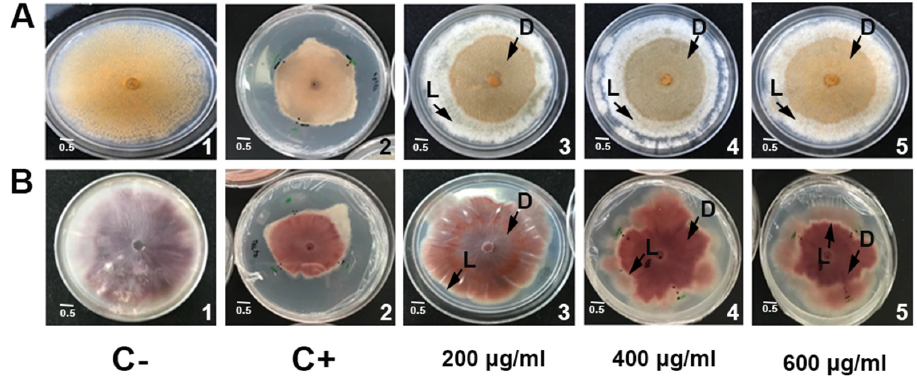
Figure 2. PaSn antifungal activity in vitro against phytopathogens using different peptide concen- trations ( A ) Colletotrichum gloeosporioides (1–5), and ( B ) Fusarium oxysporum (1–5) mycelial growth trations ( A) Colletotrichum gloeosporioides (1–5), and ( B) Fusarium oxysporum (1–5) mycelial growth inhibition. 1 : MBP, 2 : Commercial antifungal Tecto 60 (1 mg/mL), 3 : PaSn (200 µ g/mL), 4 : PaSn inhibition. 1: MBP, 2: Commercial antifungal Tecto 60 (1 mg/mL), 3: PaSn (200 μ g/mL), 4: PaSn (400 (400 µ g/mL), 5 : PaSn (600 µ g/mL). Arrows: Mycelial differential growth L : Light zone, D : Dark. μ g/mL), 5: PaSn (600 μ g/mL). Arrows : Mycelial differential growth L: Light zone, D: Dark. After 72 h incubation . After 72 h